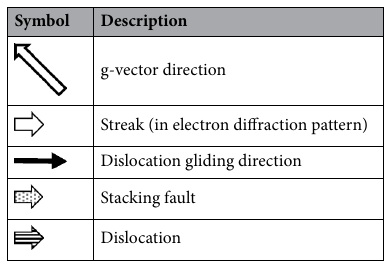
Table 1. List of symbols used in TEM